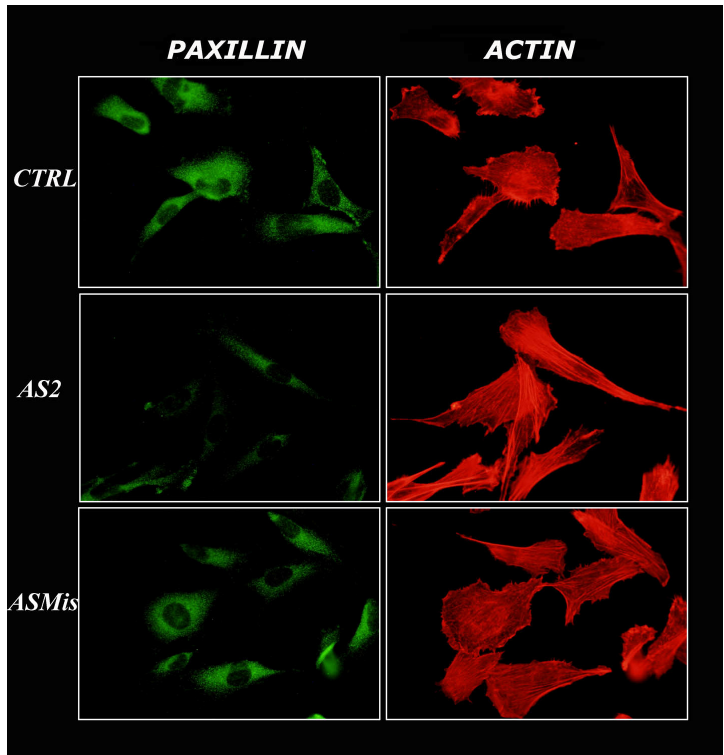
FIGURE 1. Syndecan-2 down-regulation redistributed the focal contacts and the actin cytoskeleton. HMEC-1 cells were transfected with the oligonucleotides AS2 and ASMis, and after 24 h in culture, were immunostained with paxillin mAb (focal contacts, green ) and phalloidin (actin cytoskeleton, red ). As shown, paxillin staining decreased and reorganized, while the stress fibers became prominent, typical of a migratory phenotype. One of three independent experiments is shown. (n =